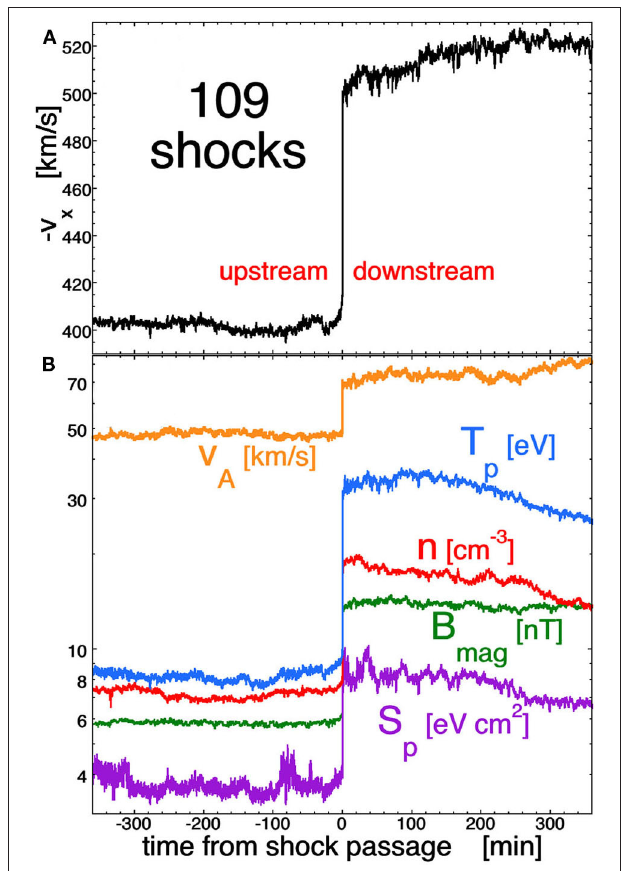
FIGURE 2 | A superposed epoch average of the plasma and magnetic-field properties of the 109 forward interplanetary shocks measured with 3-s time resolution by the WIND spacecraft. In panel (A) v x (GSE) of the solar wind is plotted. In panel (B) the magnetic-field strength (green), number density (red), Alfvén speed (orange), proton temperature (blue), and proton specific entropy S p = T p /n 2 / 3 (purple) are